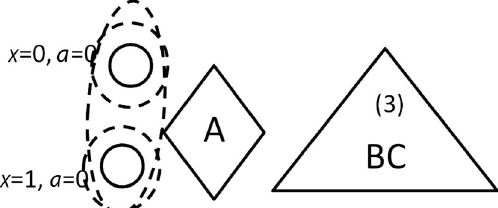
FIG. 2. A possible relaxation to bound the convex hull of Eq. (10) when Alice ’ s measurements are not trusted. Here, just Bob and Charlie have expanded bodies, represented by a triangle. The number (3) indicates the order of the moment